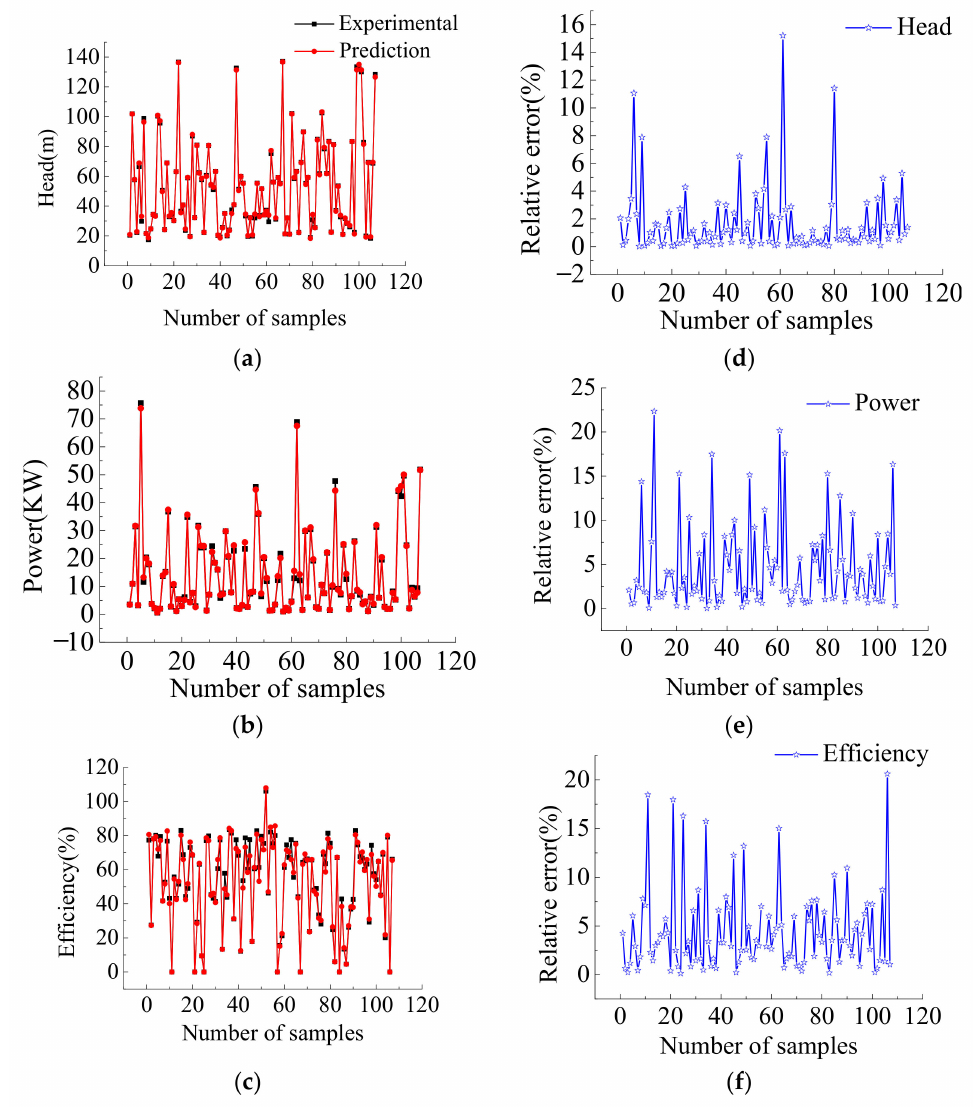
Figure 7. Comparison results of test sample. ( a – c ) are the comparison of test samples and prediction samples; ( d – f ) are the absolute relative error of head, power, and efficiency.